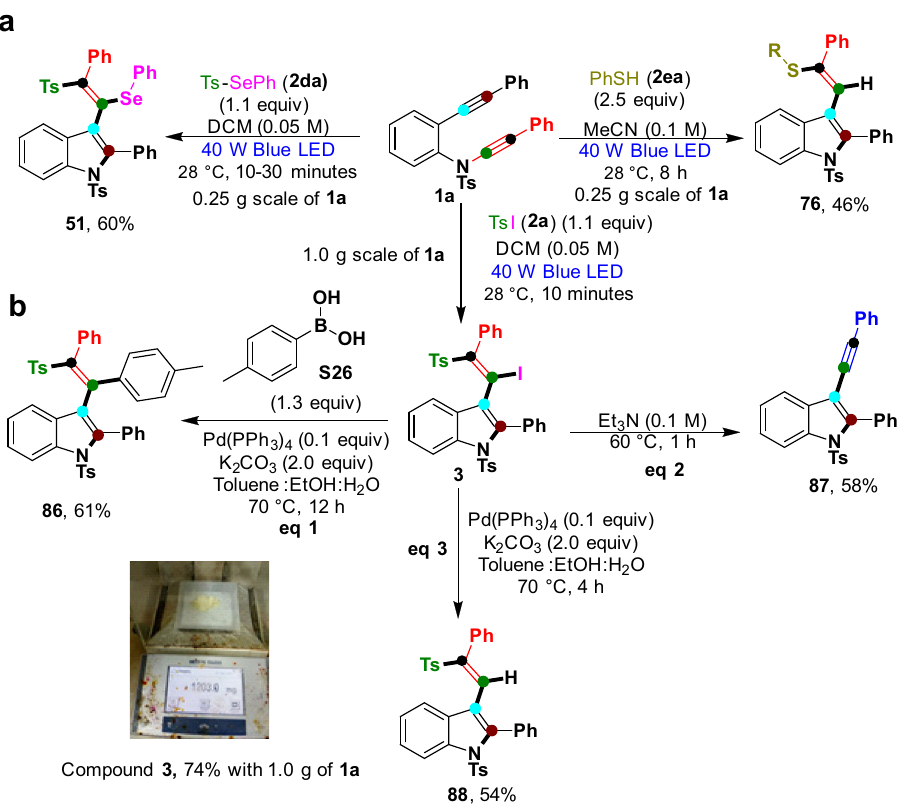
Fig. 7 Larger scale and product synthetic transformations. a Reactions on a larger scale by using 1a with radical precursors 2a , 2da , and 2ea . b Synthetic transformations of the product 3